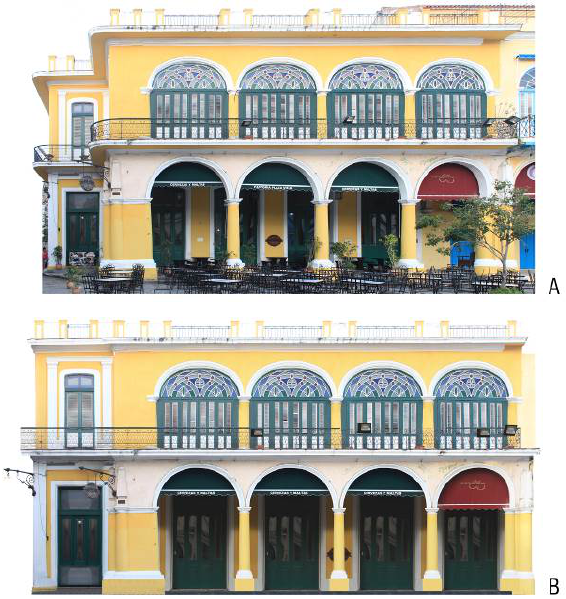
Figure 9. Comparison of the photo rectification (A) and the orthophoto map (B) of a building in Plaza